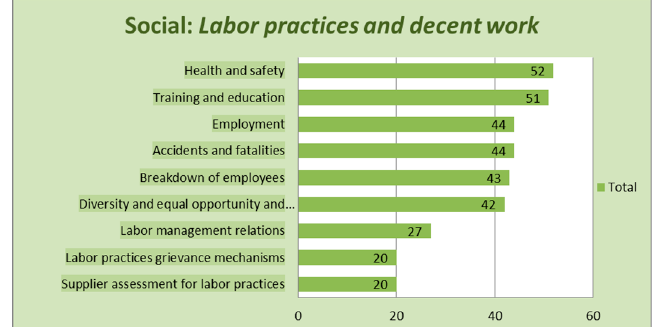
Figure 1. Tallies of occurrence of the social sustainability indicators from the category “labor practices and decent work.”